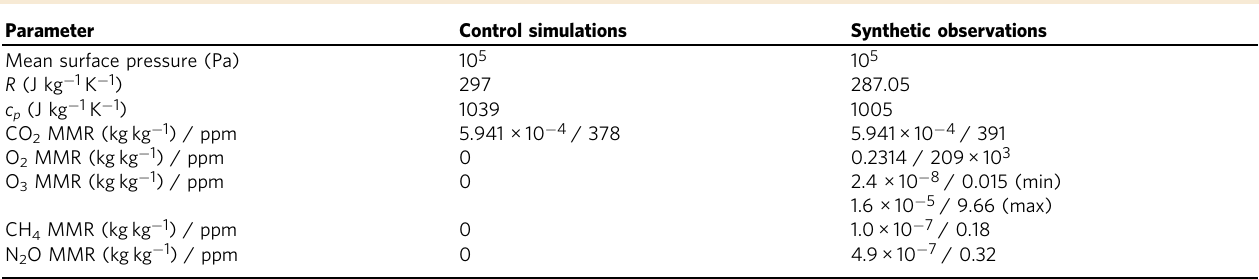
Table 2 Atmospheric parameters used in this